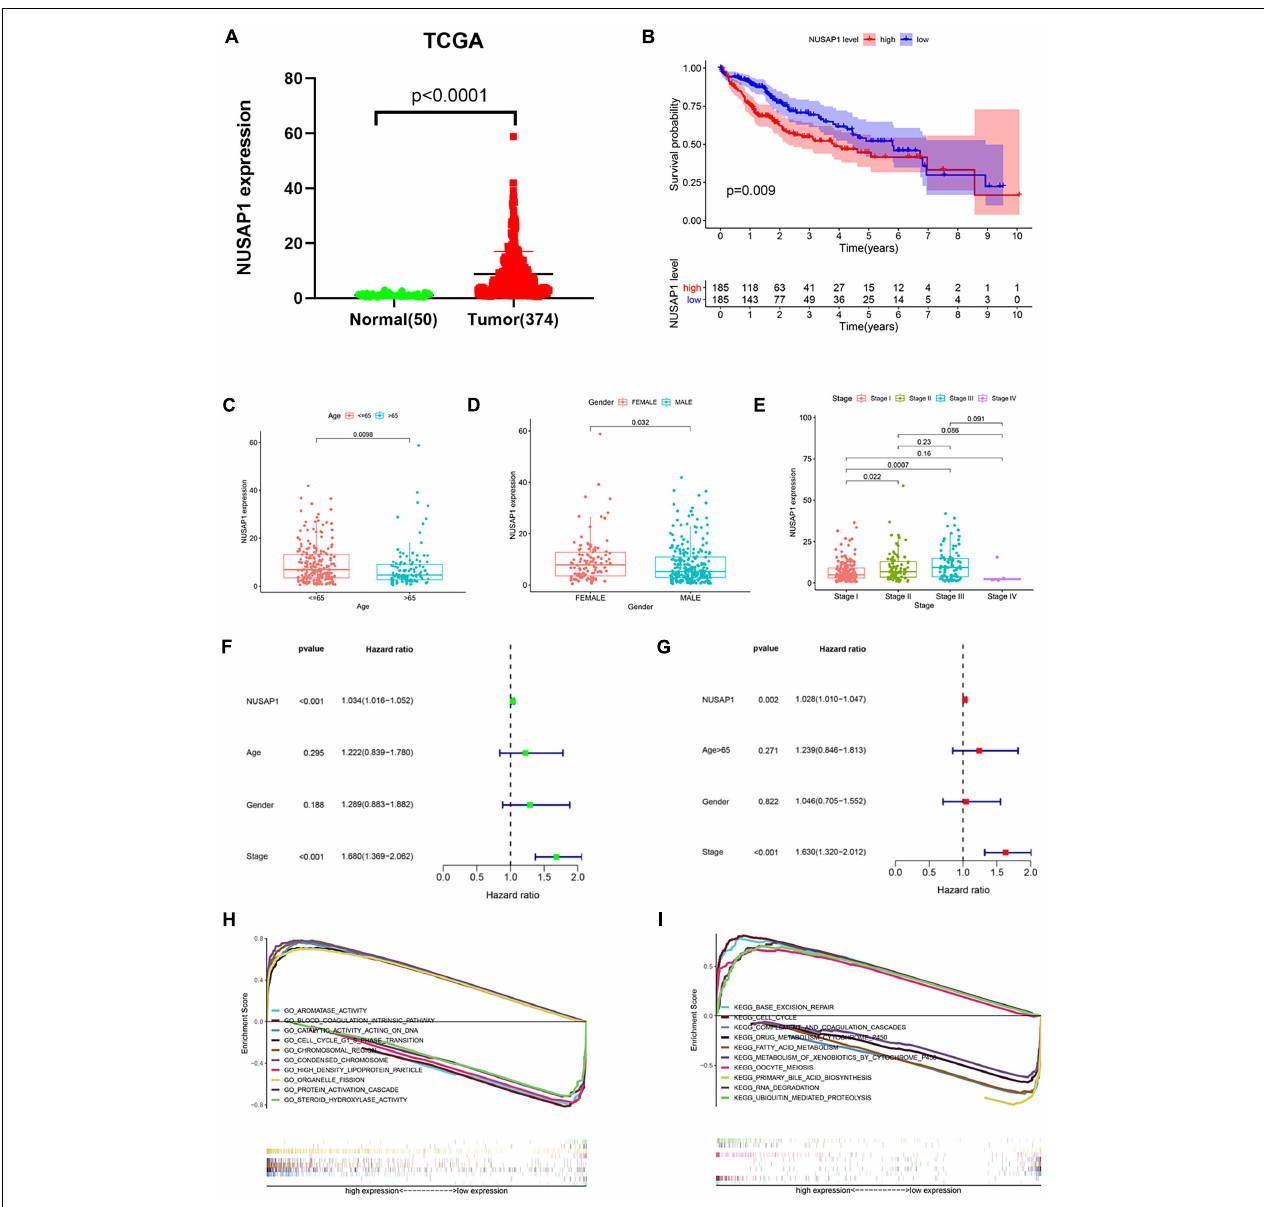
FIGURE 5 | Dot plot, Kaplan–Meier curve, box plots, forest plots, and GSEA enrichment analysis. All pictures were made by HCC patients’ expression and clinical information in TCGA database. (A) Dot plot of NUSAP1 expression in normal samples and HCC samples. (B) Kaplan–Meier curve of OS analyzed between high NUSAP1 expression group and low expression group. (C) Bar graph of NUSAP1 expression in different age groups. (D) Bar graph of NUSAP1 expression in female and male. (E) Bar graph of NUSAP1 expression in different stage groups. (F) Univariate regression analysis. (G) Multivariate regression analysis. (H) GSEA enrichment analysis, which was based on GO gene sets. (I) GSEA enrichment analysis, which was based on KEGG gene sets.